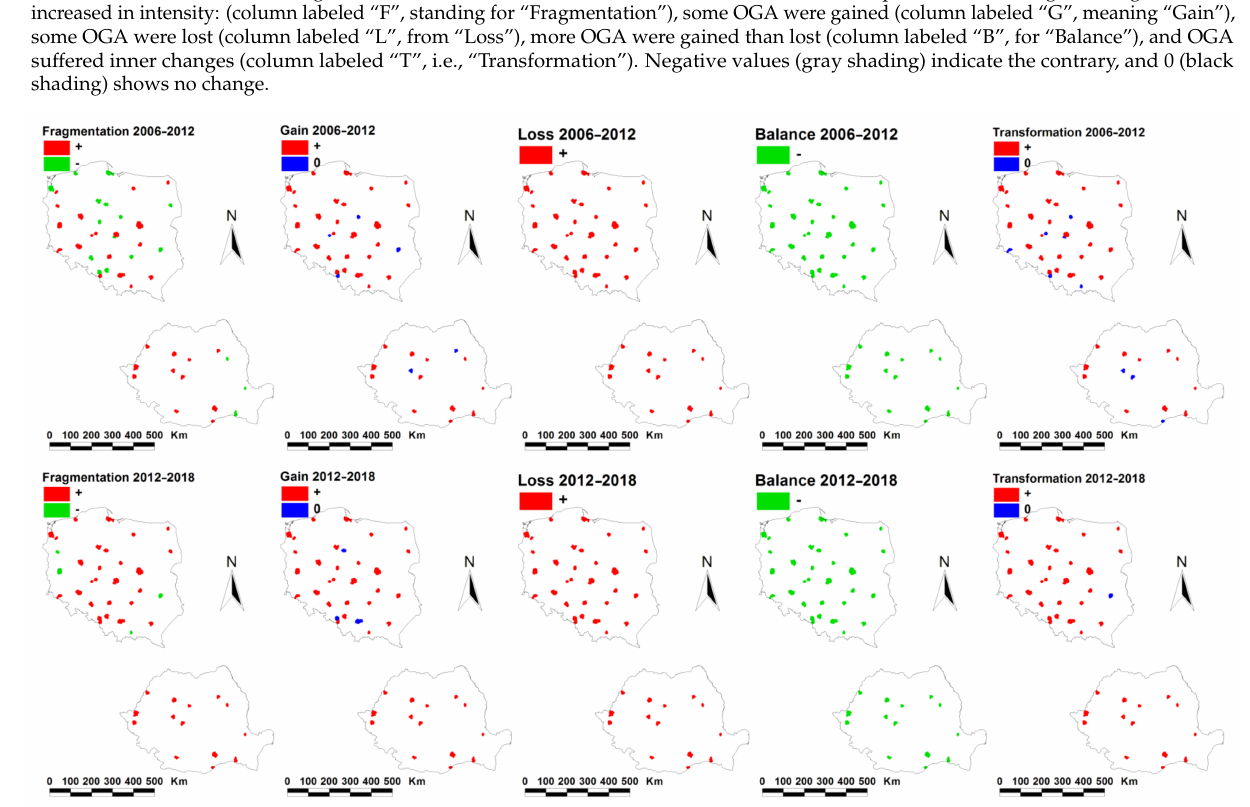
Figure 2. Dynamic of the main indicators of OGA (fragmentation, gain, loss, overall balance and transformation) in Urban Atlas Polish and Romanian cities during 2006–2012 and 2012–2018. Green indicates positive values, meaning that fragmentation increased in intensity (images labeled “Fragmentation”), some OGA were gained (“Gain”), some OGA were lost (“Loss”), more OGA were gained than lost (images labeled “Balance”), and some OGA suffered inner changes (“Transformation”). Negative values (red) indicate the contrary, and blue shows no change. The size of the cities was enlarged for a better visualization of their position and dynamics of